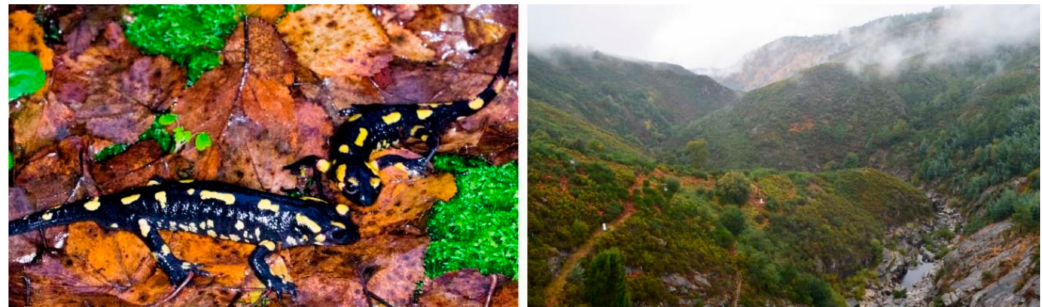
Figure 1. Adult specimens of Salamandra salamandra ( left ) (Photo: Peter Eaton). Peneda-Ger ê s National Park, habitat of S. Salamandra ( right ) (Photo: Jos é Roberto